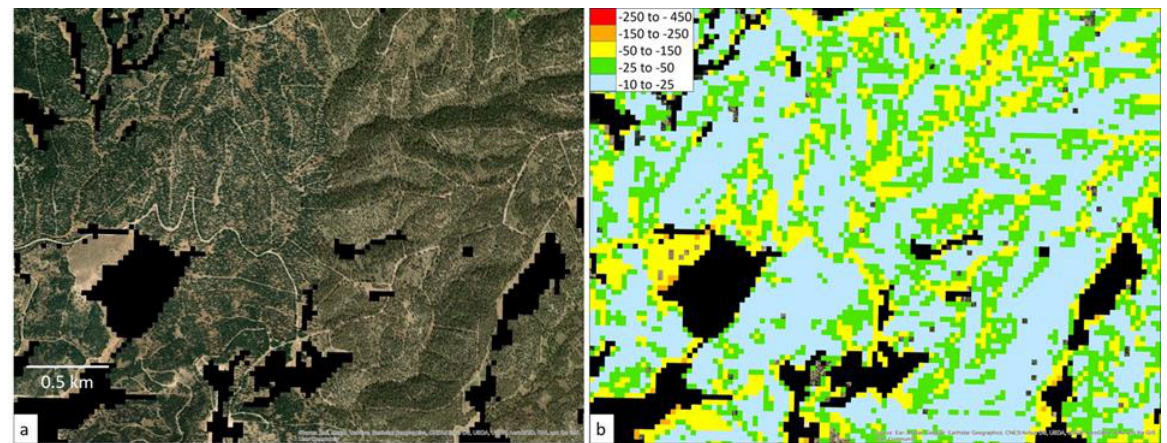
Figure 11. Aleppo Pine ( Pinus halepensis ) Plantation in Yatir forest (31°20.82′ N, 35°2.34′ E). ( a ) True color image; ( b ) LNS diff (gC m −2 yr −1 ).